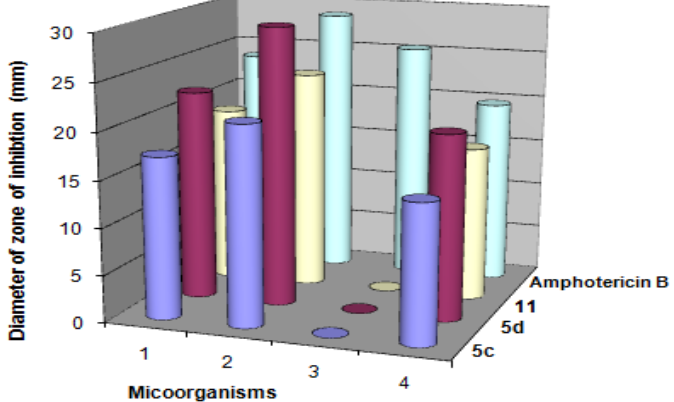
Figure 1. Antifungal activities of the synthesized compounds 5c , d and 11 against micoorganisms—1. Aspergillus fumgatus ; 2. Geotrichum candidum ; 3. Candida albicans ; 4. Syncephalastrum racemosum .